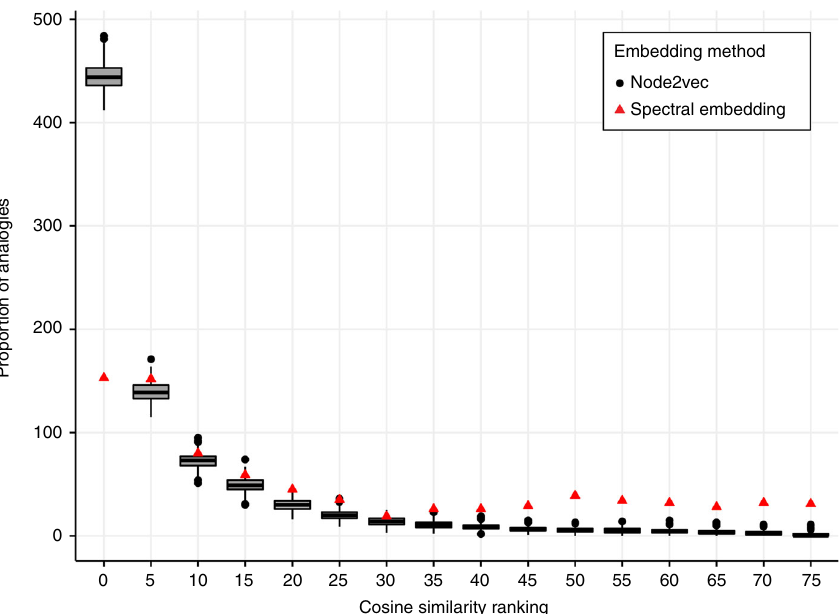
Fig. 2 Performance of two node embedding algorithms on the inter-hemispheric analogies test. The inter-hemispheric analogies test evaluated the capacity of two node embeddings to infer the relation between each pair of nodes in one hemisphere, given the same pairwise relation in the other hemisphere. Predictions across all pairwise analogies were ranked, such that a lower rank corresponds to better performance. Across 500 iterations of the node2vec algorithm, the ranking of the expected nodes were binned into bins of 5. The boxplots represent the binning of the ranking across 500 node2vec permutations. The band inside the box represents the median, the lower and upper hinges correspond to the fi rst and third quartiles (the 25th and 75th percentiles) and the whiskers represent 1.5 times the inter-quartile range (the distance between the fi rst and third quartiles). The red triangles represent the binning of the spectral ranking. Importantly, the node2vec algorithm produced a higher proportion of expected nodes in the lowest rank bin (0 – 5 ranking). Note the relatively high proportion of spectral embedding analogies with high ranking which suggest worst performance in this task. This result demonstrates that node2vec vector embeddings successfully encompass functional homotopy